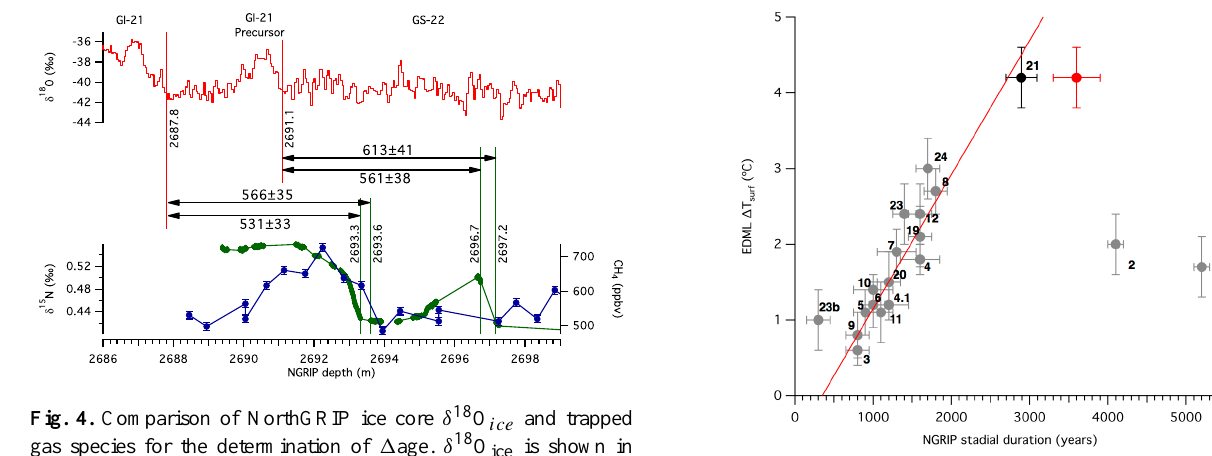
Fig. 5. Comparison of NGRIP stadial duration and EDML tempera- ture change, modified from Capron et al. (2010a). Numbers indicate corresponding GI and AIM events, where the stadial duration is de- termined from the GS prior to the numbered GI. The durations of GS-22 (together with GI-21 corresponding to AIM21 in the figure) are shown for both EDML-synchronized (red, Capron et al., 2010b) and annual-layer counted (black, this study) NGRIP